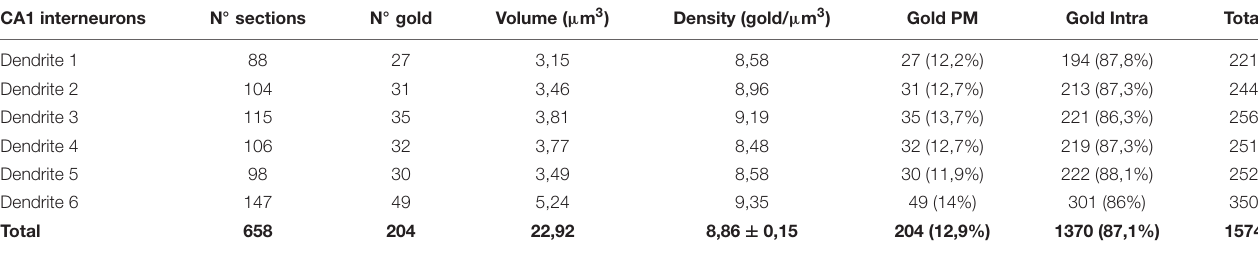
TABLE 2 | Distribution of SK2 immunoparticles on 3D reconstructed dendritic shafts of interneurons. PM, Plasma membrane; Intra, intracellular. CA1